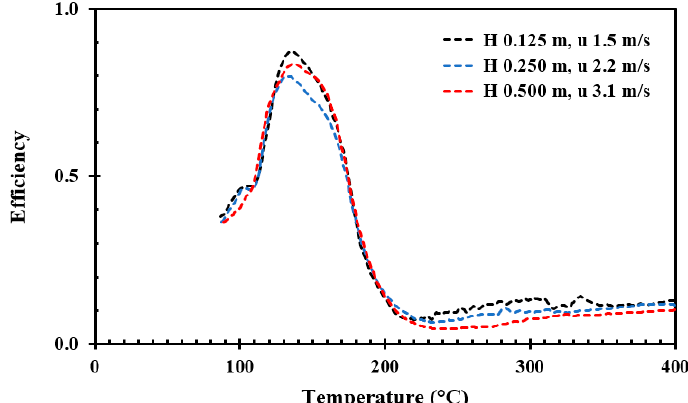
Figure 18. Cooling efficiency for 300 ppm acetone solution for droplet diameter 2.5 mm, horizontal orientation. Impingement heights and speeds are given in the figure label.